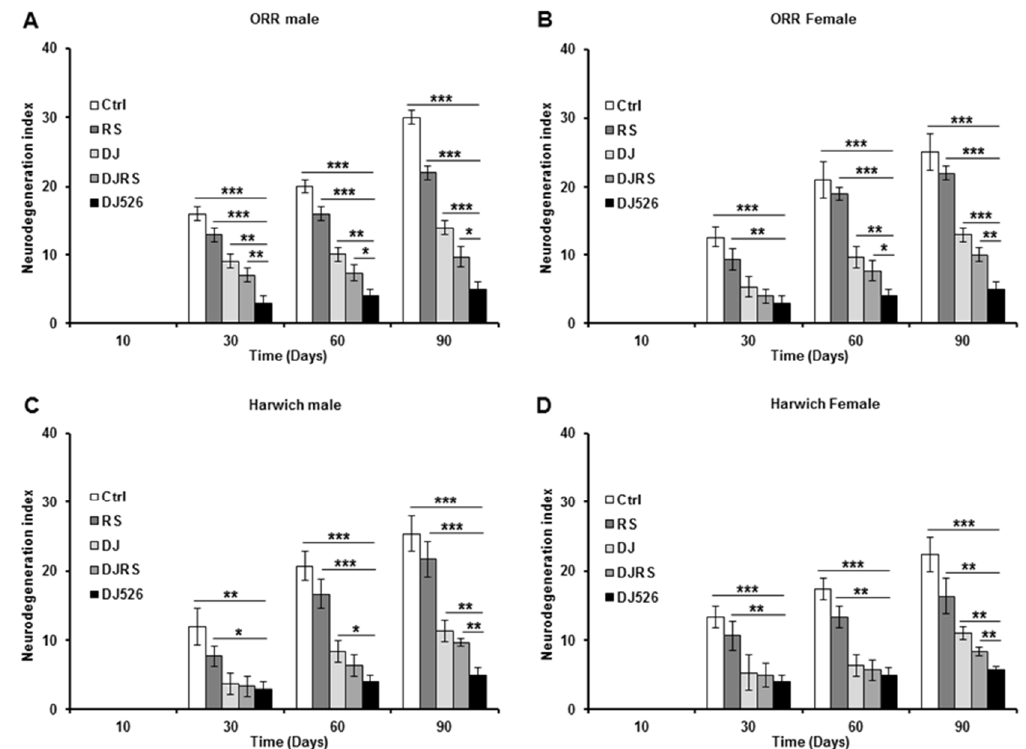
Figure 6. The resveratrol rice DJ526 suppressed age-related neurodegeneration in D. melanogaster . ( A ) ORR males, ( B ) ORR females, ( C ) Harwich males and ( D ) Harwich females. Ctrl represents standard cornmeal medium; RS represents cornmeal medium supplemented with resveratrol at 31.54 µ g / L, the equivalent amount of resveratrol found in the DJ526 media; DJ represents the medium in which 50% of cornmeal was replaced with Dongjin rice; DJRS represents the medium in which 50% of cornmeal was replaced with Dongjin rice and supplemented with resveratrol at 31.54 µ g / L, and DJ526 represents the medium in which 50% of the cornmeal was replaced with the resveratrol rice DJ526 (Table S1). The quantification of the neurodegeneration and vacuolar lesions based on the histological analysis of the Drosophila brains were observed at the 10th, 30th, 60th and 90th days post-eclosion. Statistical significance was analysed with an unpaired Student’s t -test and indicated as * p < 0.05, ** p < 0.01, and *** p < 0.001 from three independent experiments (n = 30).